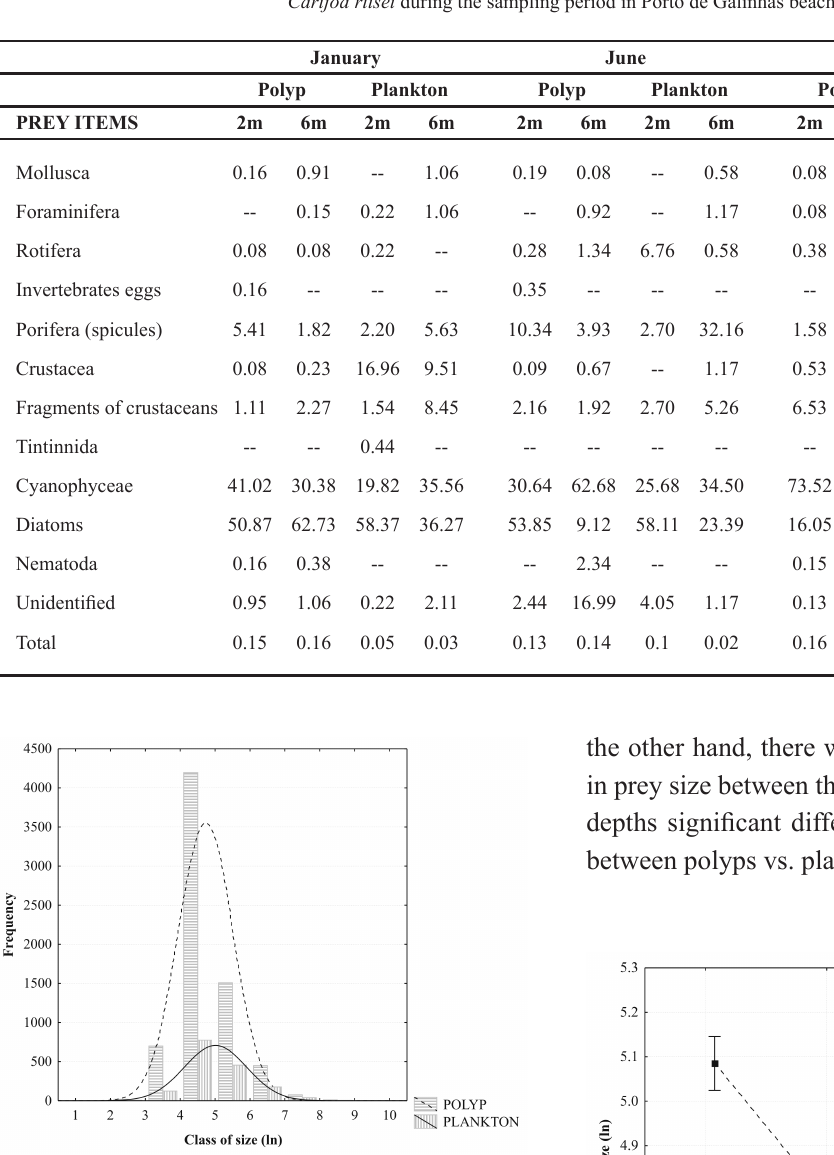
Fig. 2- Size-frequency histogram of prey found in gastric cavities of the polyps of Carijoa riisei and in the plankton at Porto de Galinhas beach